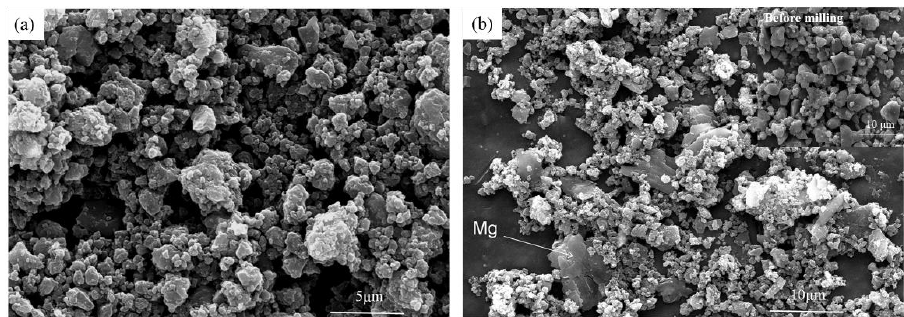
Figure 4. FESEM images of Mg/B2 composite powders cryomilling for ( a ) 3 h and ( b ) 9 h.